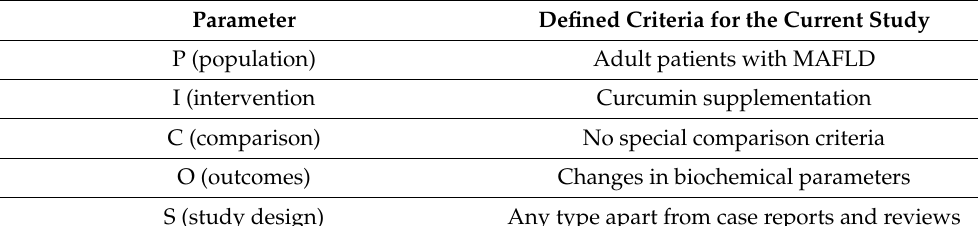
Table 1. PICOS criteria for inclusion and exclusion of studies.